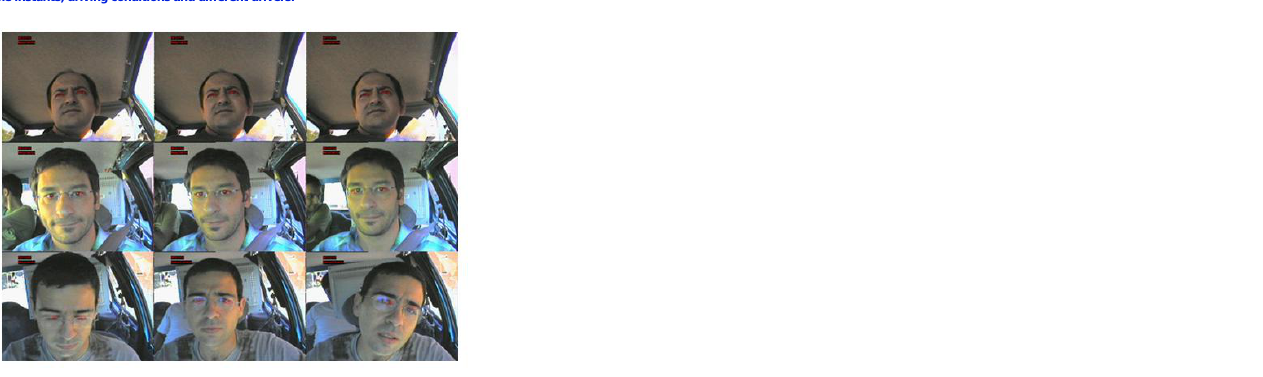
Figure 25 Different stages of the proposed algorithm during daytime conditions and for several time instants, driving conditions and different